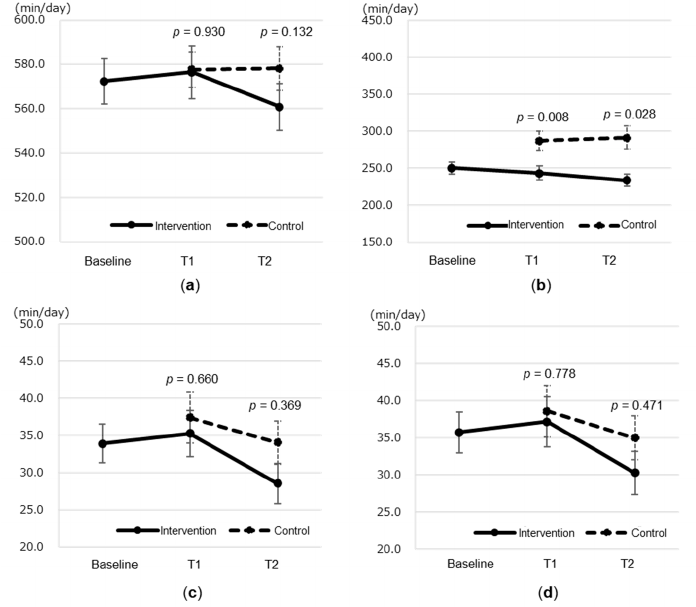
Figure 3. Effects of sedentary behavior (SB) and physical activity (PA) in the intervention and control groups. (a) SB, (b) Light PA, (c) Moderate PA, and (d) Moderate-to vigorous PA. Plots of the mean values at three time points. Solid lines represent the intervention group, and dotted lines represent the control group. Error bars indicate the mean error. T1: Student’s t -test was used to compare the two groups. T2: Analysis of covariance was used to compare the two groups (fixed effects: intervention/control; covariates: values at T1). Intervention group: baseline ( n = 56), T1 ( n = 55), T2 ( n = 54). Control group: T1/T2 ( n = 34). Table 2. Pregnancy and delivery parameters.